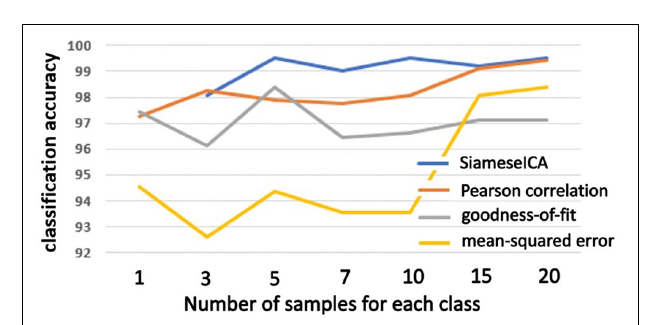
FIGURE 7 | Plots of classification accuracy on the CNRM dataset with different number of examples trained for the proposed SiameseICA model and majority voting over different number of reference samples for Pearson correlation, goodness-of-fit and mean-squared error methods. Our method obtains 100% classification with five training samples.